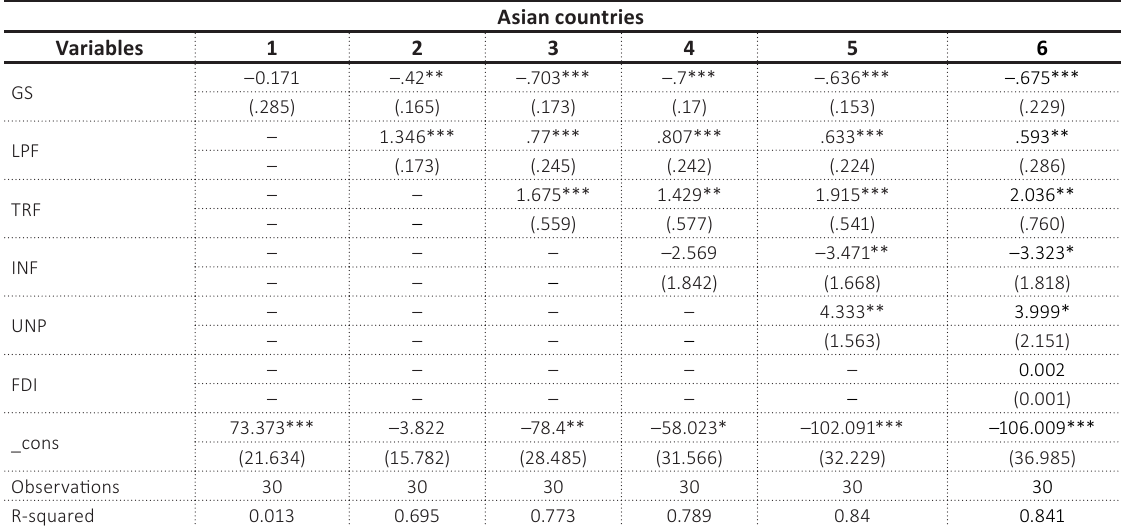
Table 6. OLS results of Asian